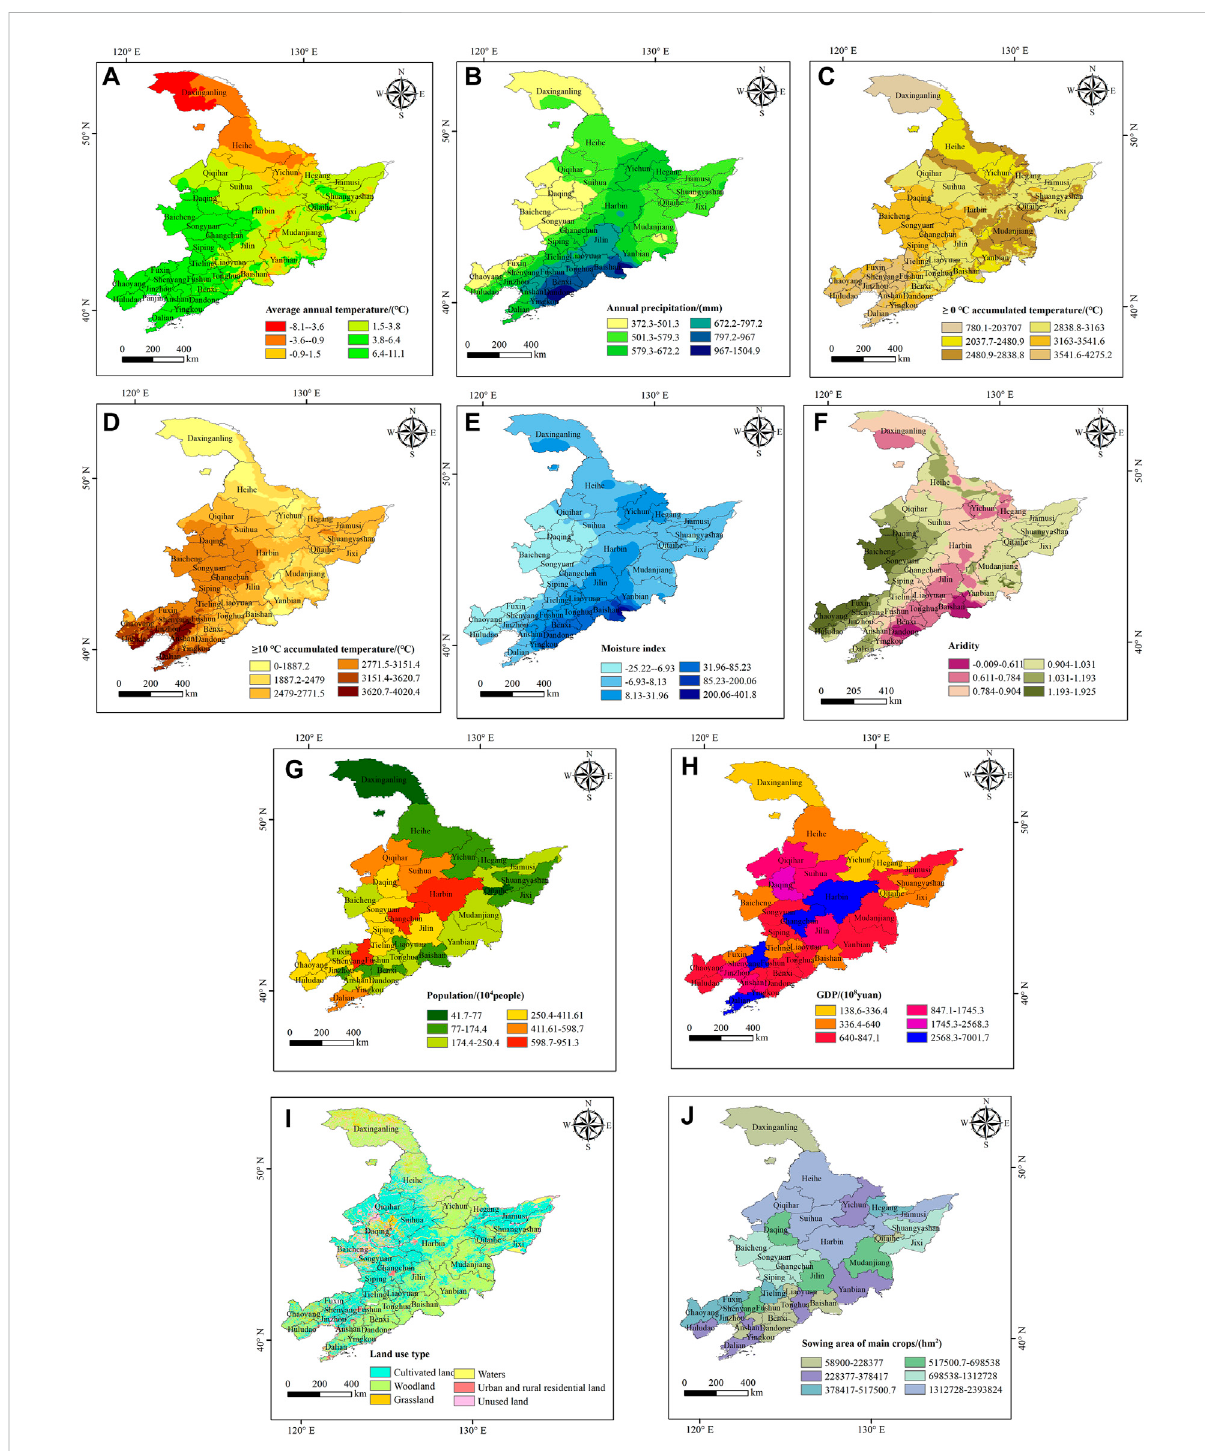
FIGURE 2 NDVI drivers and spatial distribution in the three northeast provinces. (A) : Annual average temperature map; (B) Annual precipitation map; (C) ≥ 0 ° Caccumulated temperaturemap; (D) ≥ 10 ° Caccumulated temperaturemap; (E) Moistureindexmap; (F) Ariditymap; (G) Population map; (H) GDP map; (I) Land use type map; (J) Sowing area of main crops